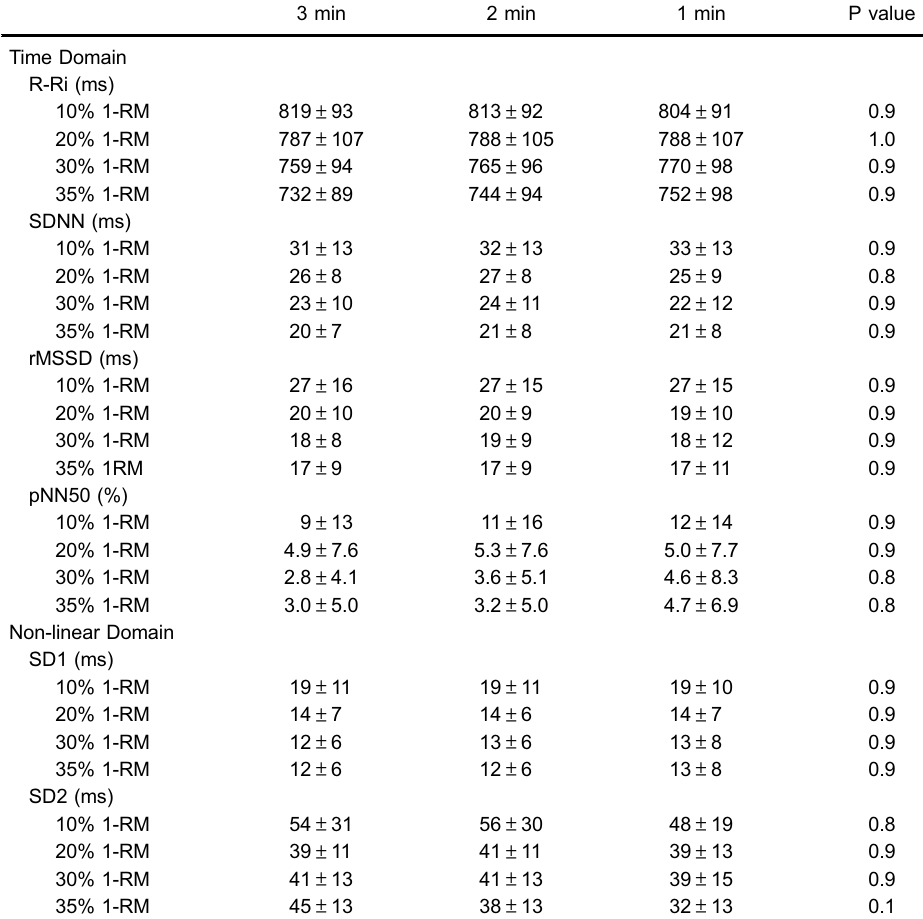
Table 2. Average linear and non-linear heart rate variability parameters calculated over 3, 2, and 1 min signals recorded at different exercise intensities. 3